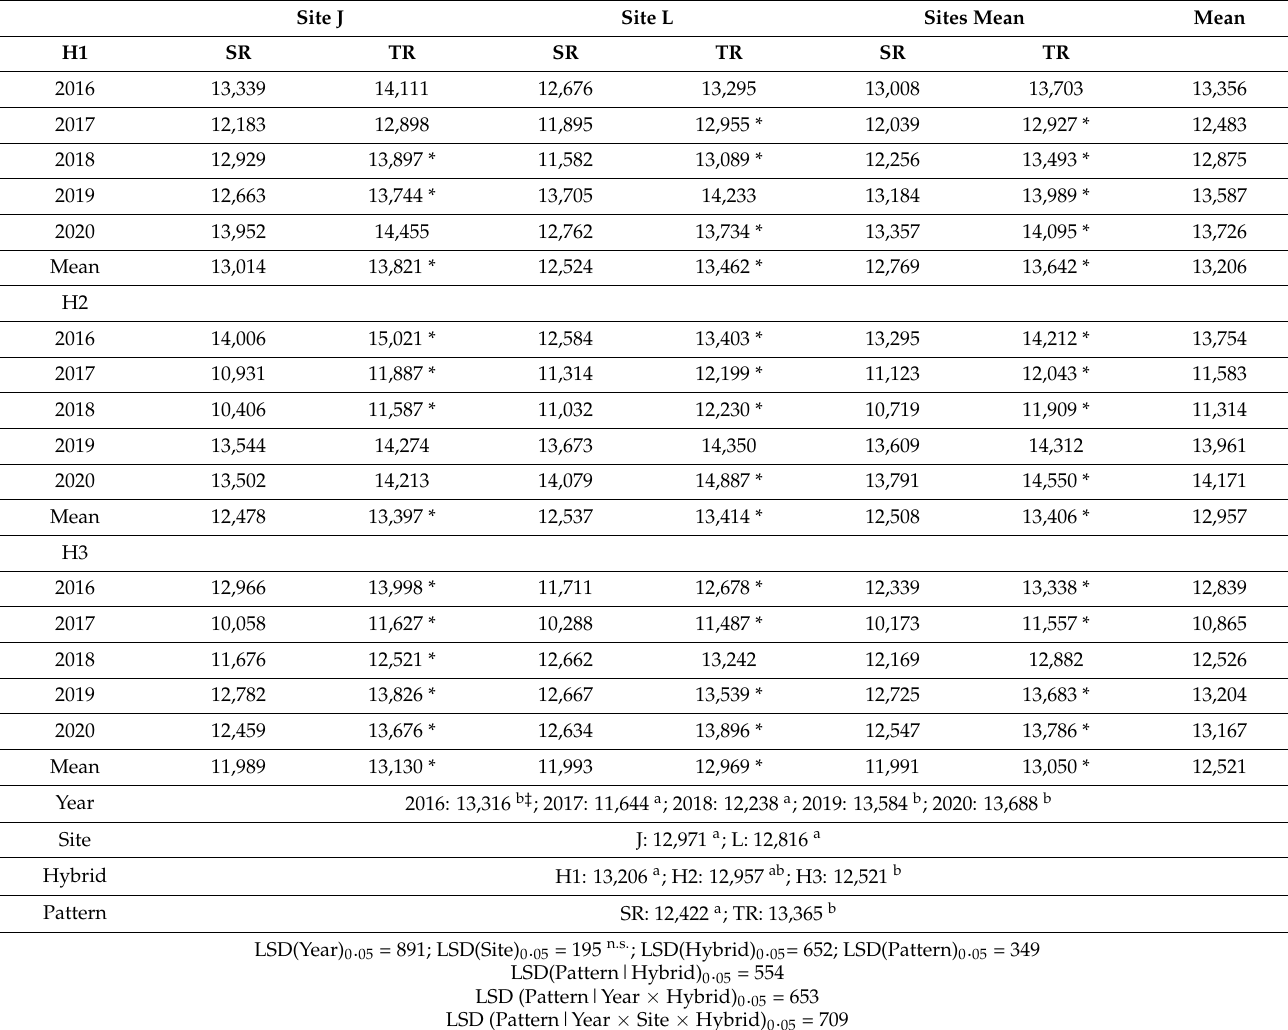
Table 4. Maize grain yields (kg ha − 1 ) of three hybrids (H1: Kashmir, H2: Kapitolis and H3: Konfites) at two sites (J: Jakši´c, L: Lužani) and using two seeding patterns (SR: single-row, TR: twin-row) during the seasons